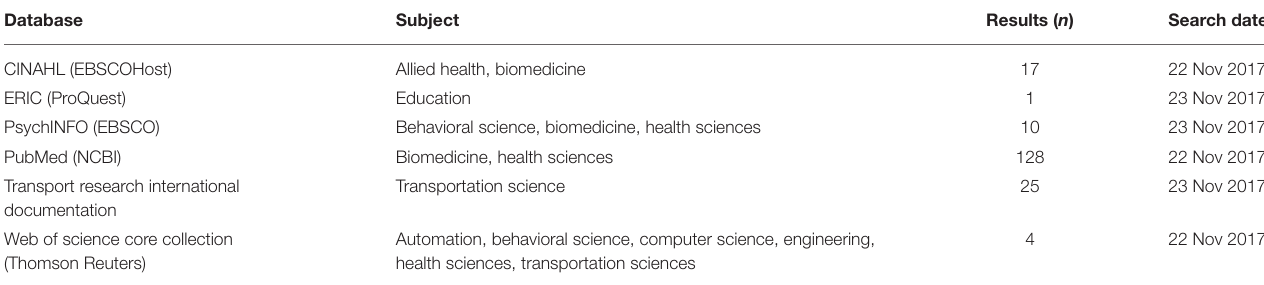
TABLE 1 | Database searched by subject, results and search